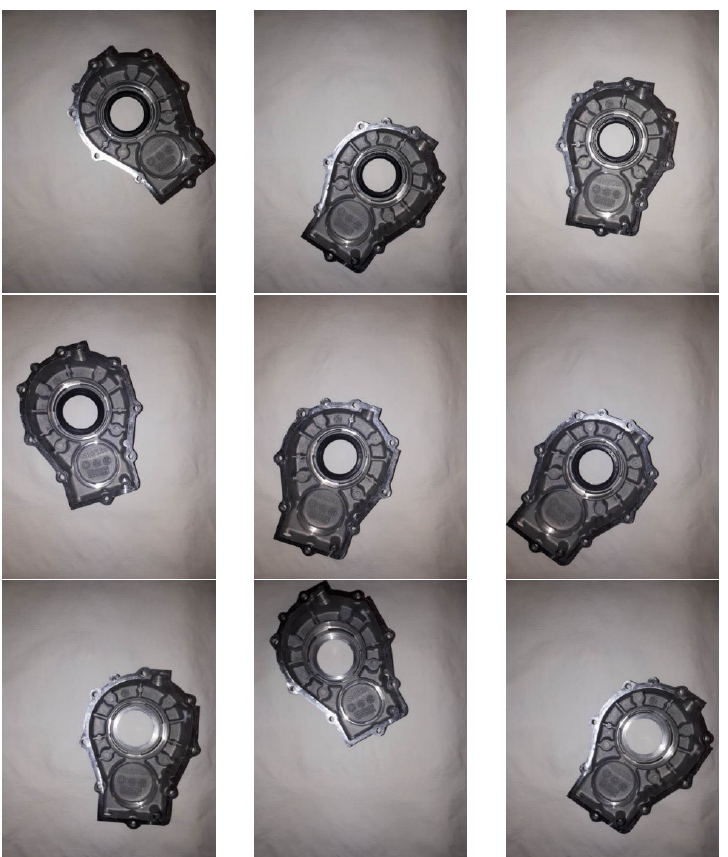
Figure 19. Example images of the data collected. The first three pictures represent the correct position of the oil seal, the second three the oil seal positioned upside-down, and the last three is the absent oil seal.